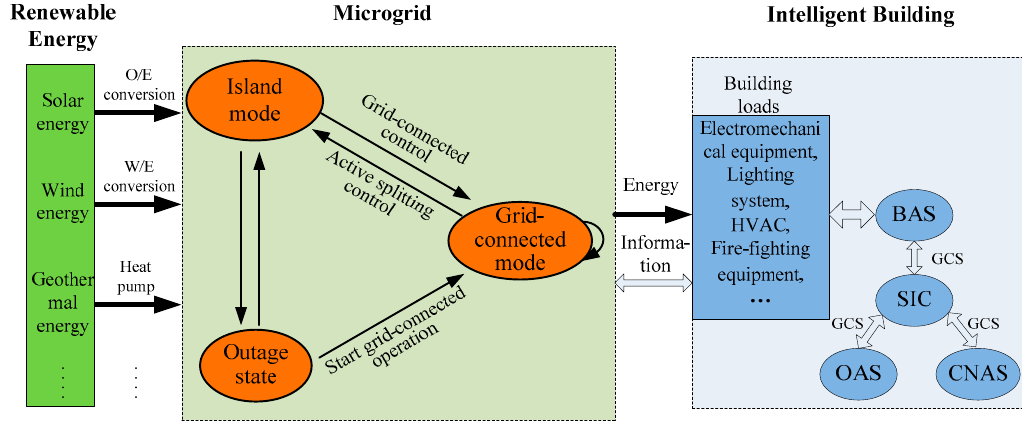
Figure 2. Structure of the microgrid-enabled intelligent building.